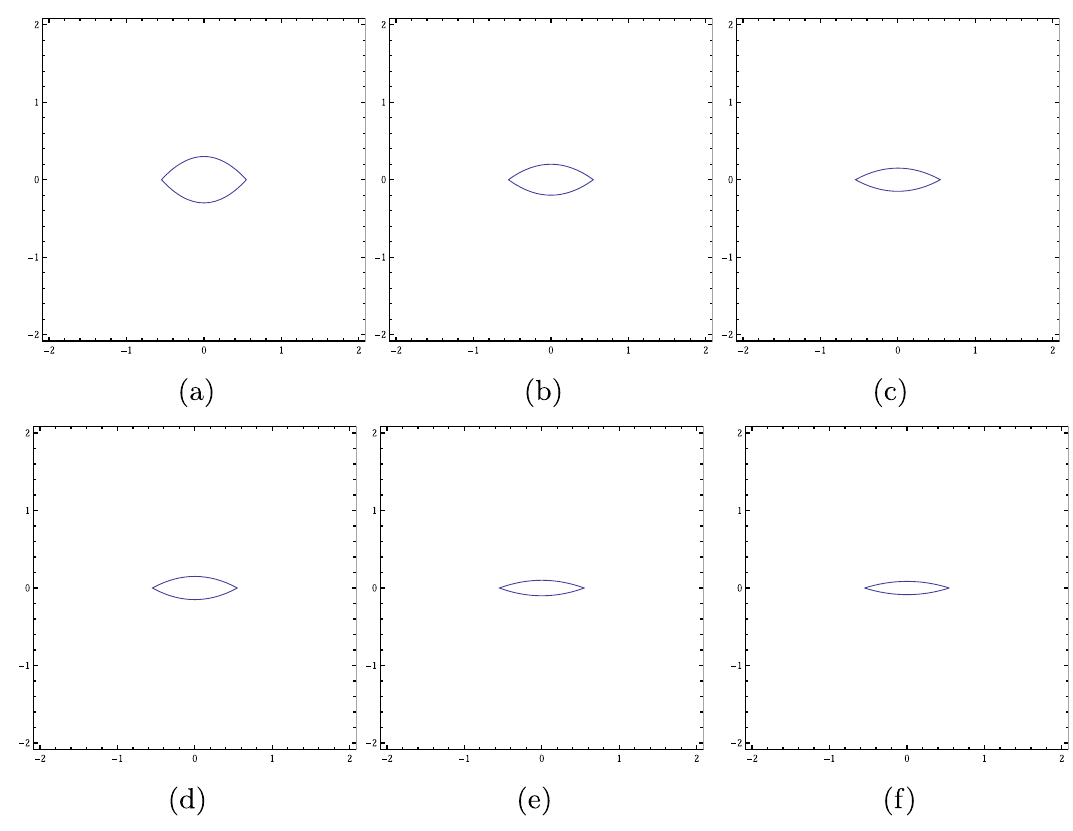
Figure 1: The shape of metric ball ( ) B 0 tψ when we fi x = t 0.3 , = a 1 , and b takes the values from 1 to 3.5 in the interval of 0.5.